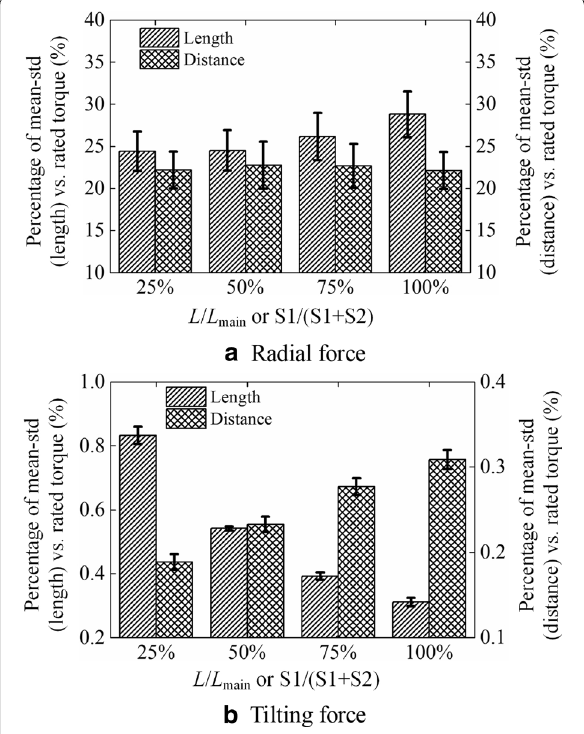
Figure 13 Carrier bearing forces in two suspension